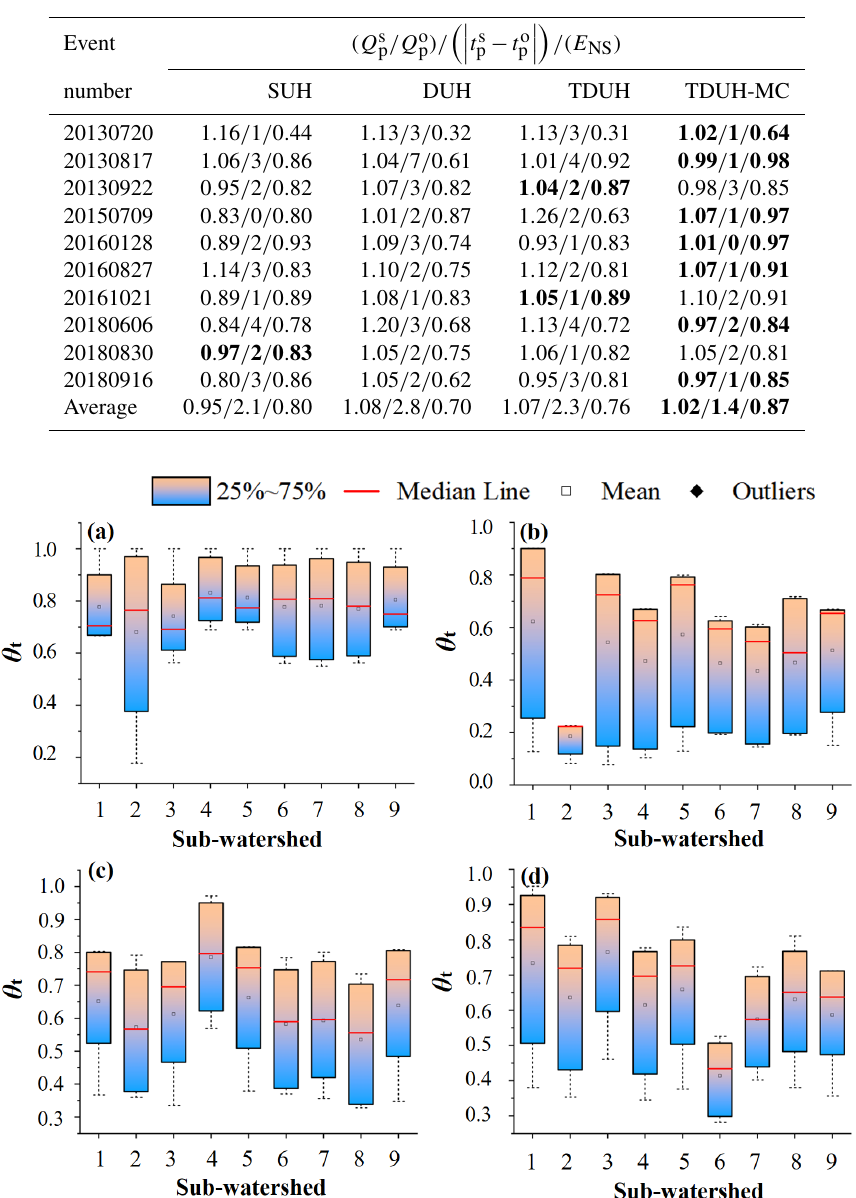
Figure 14. Distributions of time-varying θ t at different times in each sub-basin using the TDUH-MC method. (a) Flow event no. 20130817. (b) Flow event no. 20150709. (c) Flow event no.20160128. (d) Flow event no. 20180916. θ t represents the ratio of current soil moisture storage to the corresponding maximum soil moisture capacity in the unsaturated